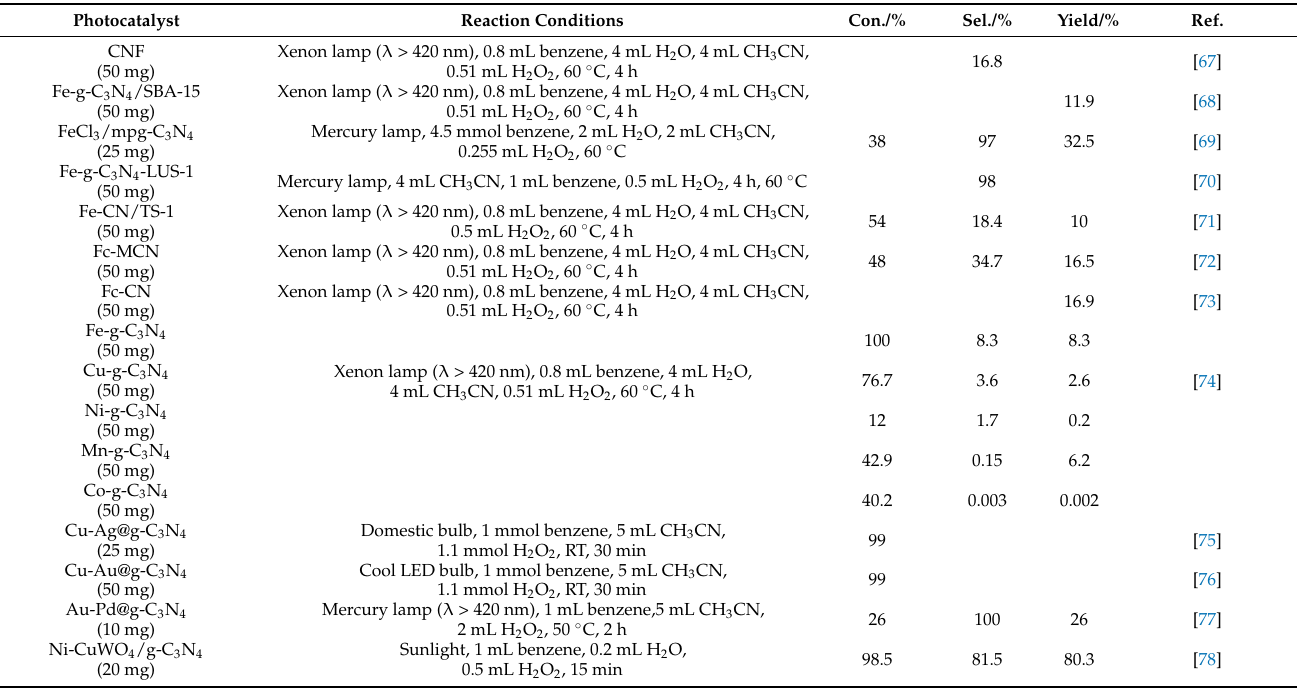
Table 3. Catalytic performance of g-C 3 N 4 -based photocatalysts for benzene